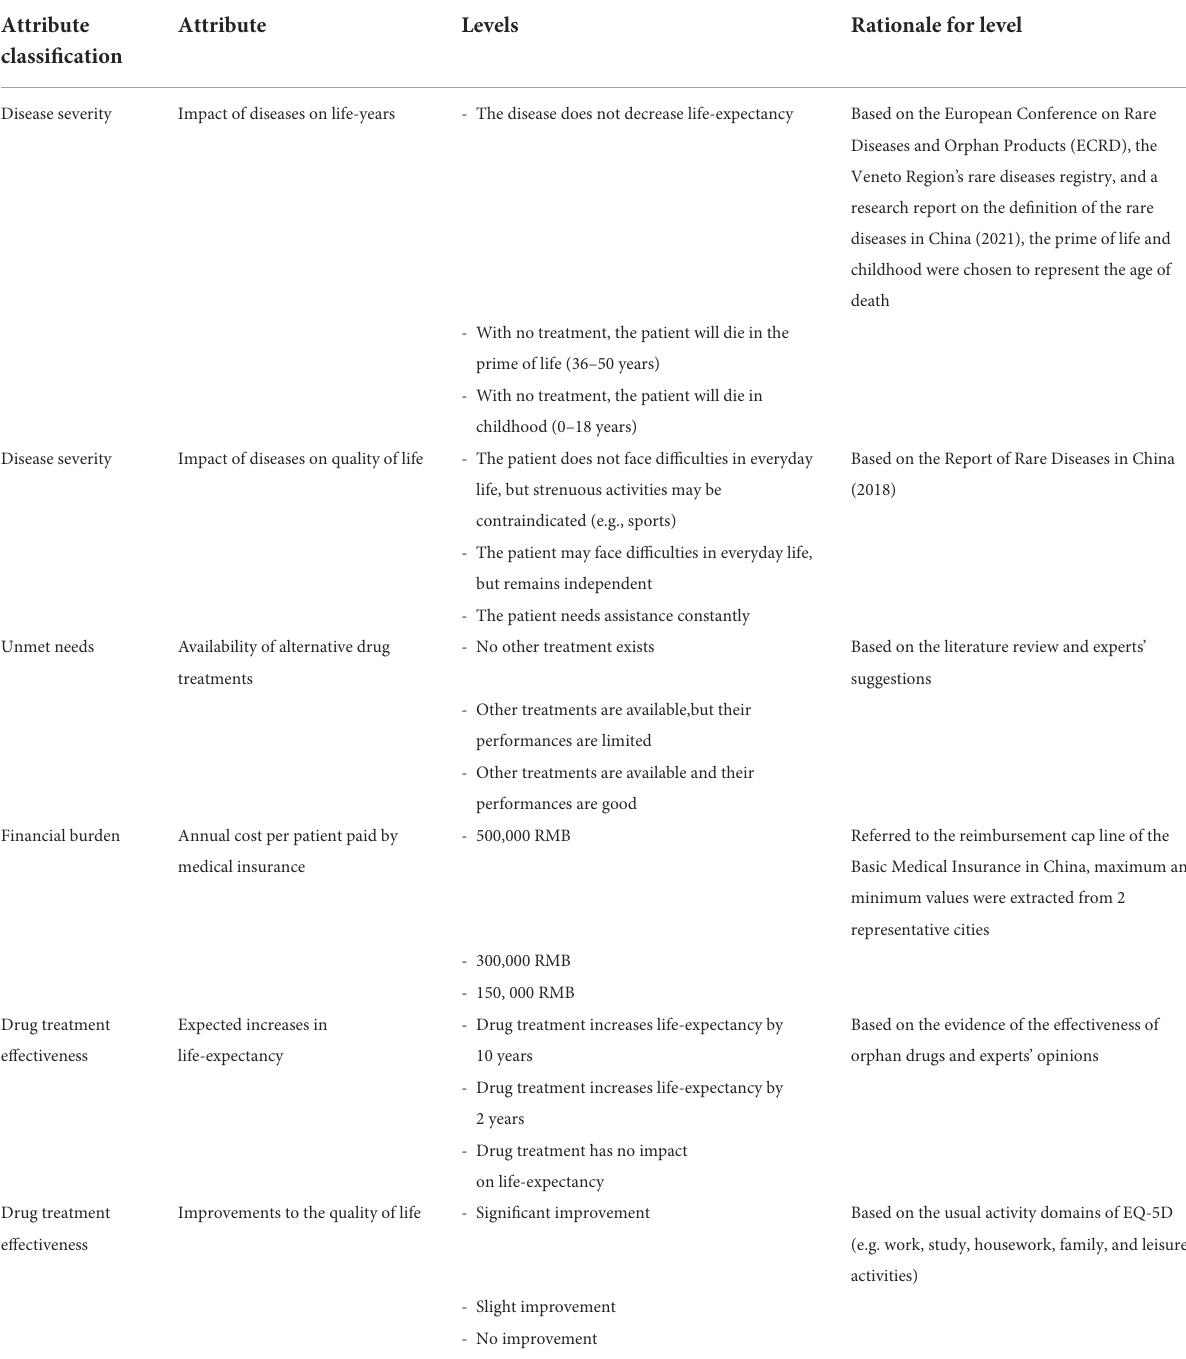
TABLE 1 Discrete choice experiment attributes and